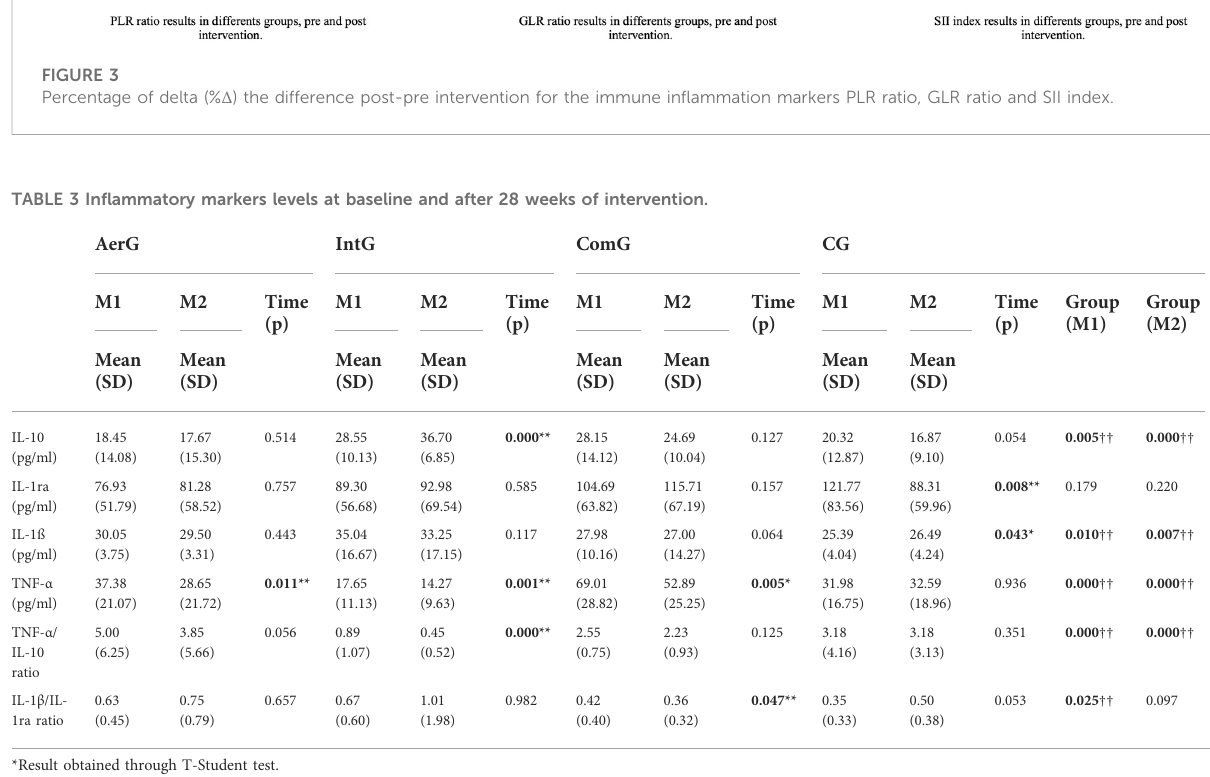
*Result obtained through T-Student test. **Result obtained through Wilcoxon test. † Results obtained through ANOVA e Tukey test. †† Results obtained through Kruskal Wallis and Bonferroni test. Bold are intended to highlight the variables where statistically signi fi cant differences were found. SD, standard deviation; AerG, continuous aerobic group; IntG, aerobic interval group; ComG, combined group; CG, control group; IL-10, Interleukin 10; IL-1ra, interleukin 1;